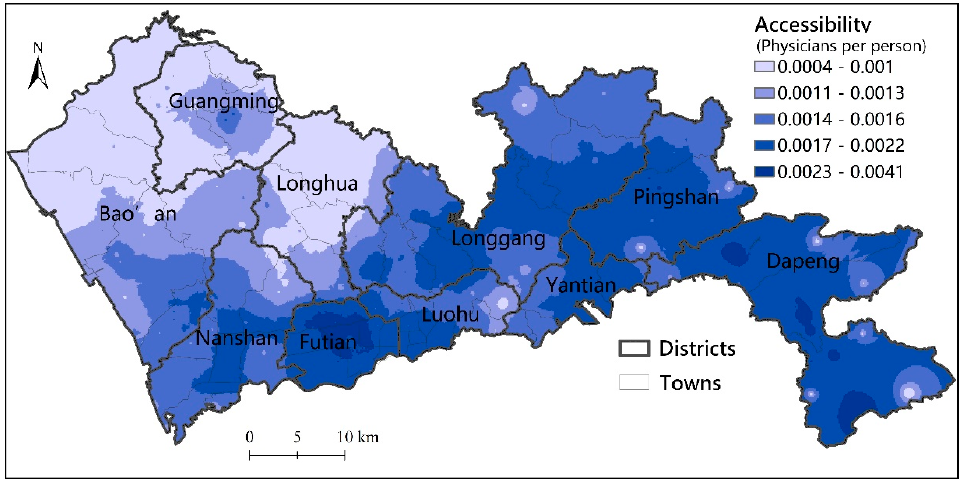
Figure 6. The distribution of healthcare accessibility after improving utilization efficiency in Shenzhen.